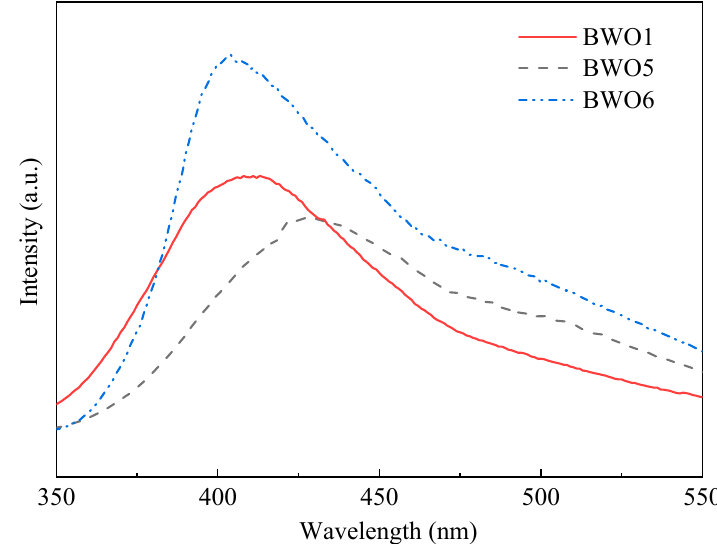
Figure 6. Photoluminescence (PL) spectroscopy of the synthesized samples at different conditions. BWO1: 12 h, 160 °C. BWO5, 24 h, 200 °C. BWO6: 24 h, 200 °C. pH = 10.